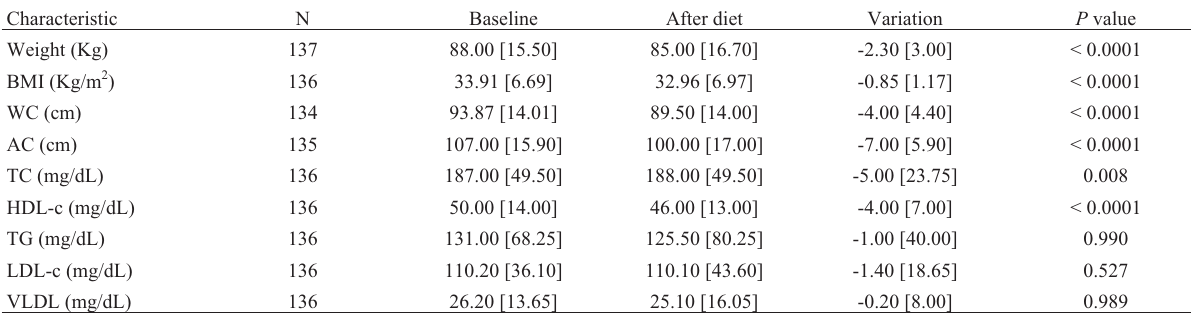
Table 2 - Characteristics at baseline, after-diet moment and the variation in response to diet (median [IQR]).